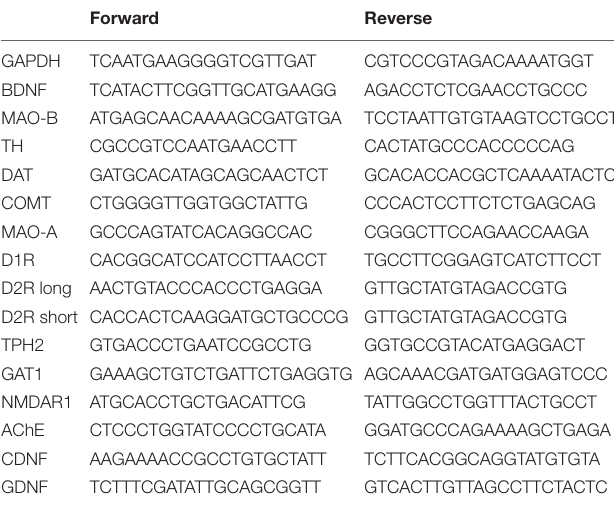
TABLE 1 | | Primer sequences for